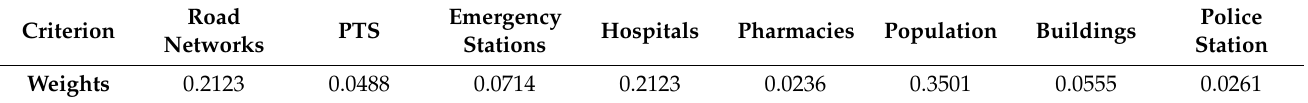
Table 4. Weight of evaluation